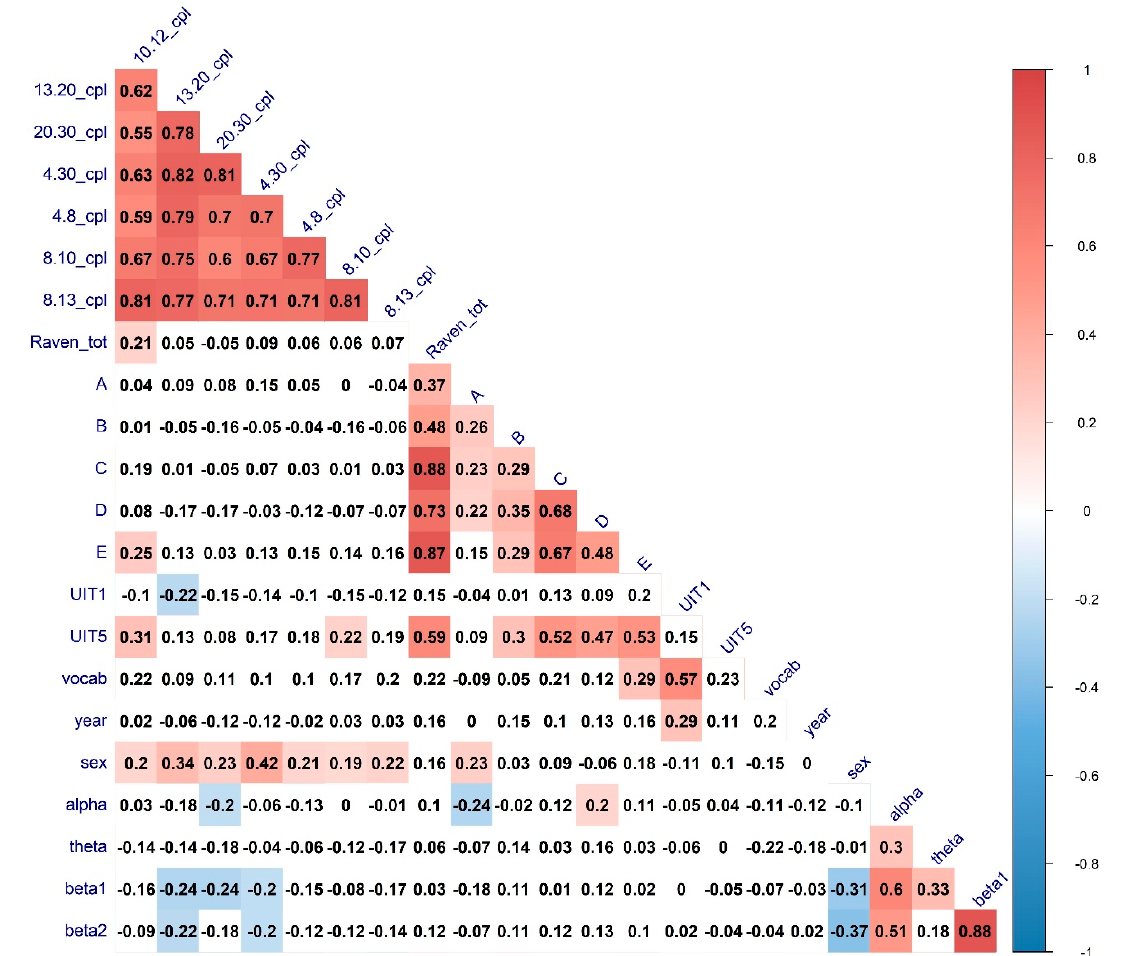
Figure 4. The heatmaps of the correlations between cognitive abilities measures, characteristic path length, sex, age, and EEG Frequency bands power. Correlations of significance level p < 0.05 are marked in color. CPL—Characteristic path length —Modularity; UIT1—“Awareness” verbal subtest, UIT5—“Conclusion” subtest of the Universal Intellectual Test, vocab—“MyVocab” test. The results are adjusted for multiple comparisons with the FDR method. Table 5. The results of the partial correlation analysis between the EEG measures, verbal and non-verbal cognitive variables, and potential regressors.